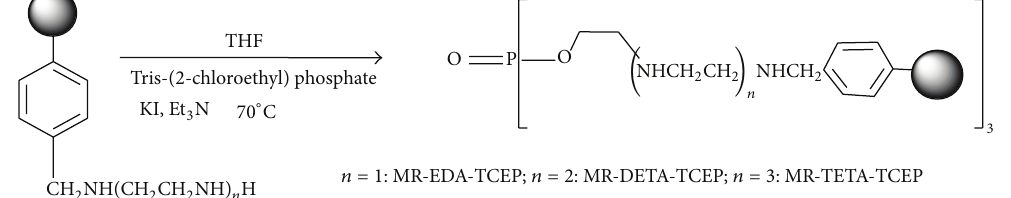
Figure 2: Proposed synthesis of MR-EDA-TCEP, MR-DETA-TCEP, and MR-TETA-TCEP resins.